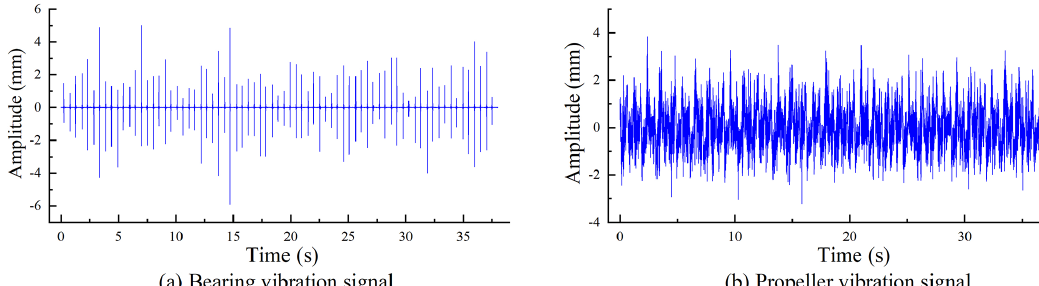
Figure 3. Analysis of the vibration signals in the time